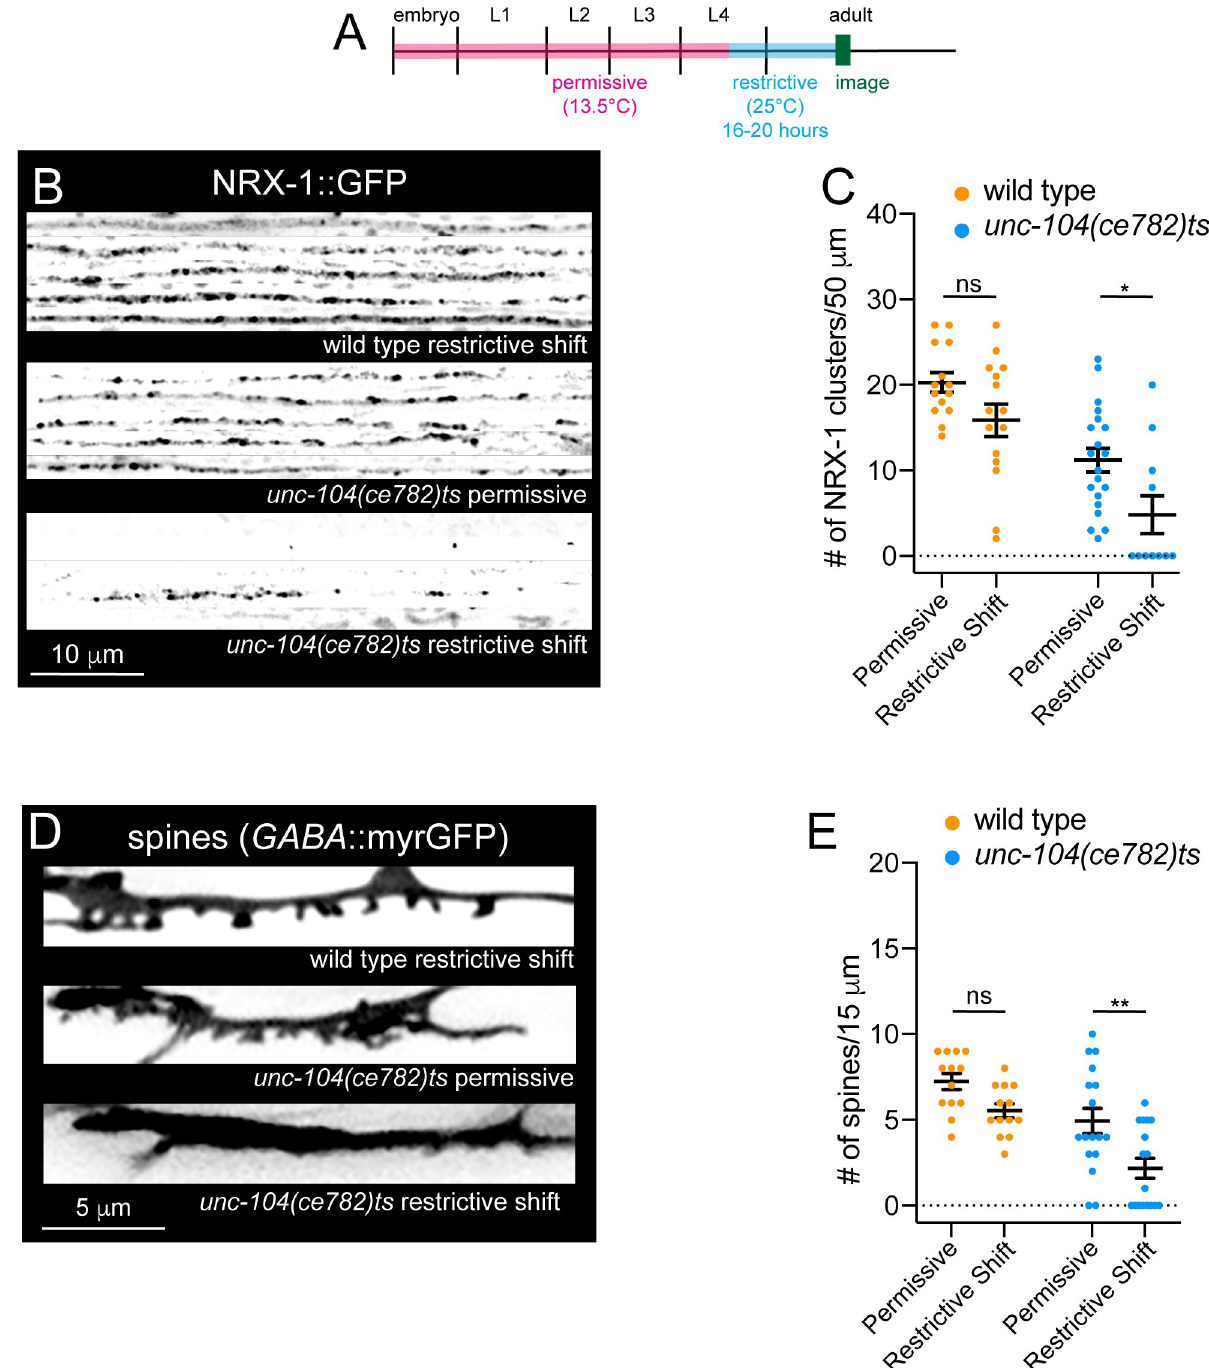
Fig 5. UNC-104/KIF1A transport of NRX-1 is required in the mature circuit to maintain postsynaptic structure. (A) Cartoon depiction of experimental timeline. Animals were grown at 13.5˚C until L4 stage before shifting animals to the restrictive temperature of 25˚C for 16–20 hours and imaging. (B) Line scan fluorescent images of NRX-1::GFP (knock-in to endogenous locus, inverted LUT) from dorsal cords of wild type and unc-104 (ce782) mutants grown continuously at the permissive temperature (13.5˚C) (middle panel) or shifted to the restrictive temperature (25˚C) (bottom panel) at L4 stage for 16–20 hours before imaging (bottom panel). Each line scan indicates an individual animal. (C) Quantification of NRX-1::GFP clusters along a 50 μ m region of the dorsal nerve cord in wild type and unc-104(ce782)ts animals. Two-way ANOVA, Tukey’s multiple comparisons test, ns, not significant, � p < 0.05, n � 11 animals. Data points indicate mean ± SEM. (D) Fluorescent images of DD spines in wild type and unc-104 (ce782)ts animals grown continuously at the permissive temperature (13.5˚C) (middle panel) or shifted to the restrictive temperature (25˚C) (bottom